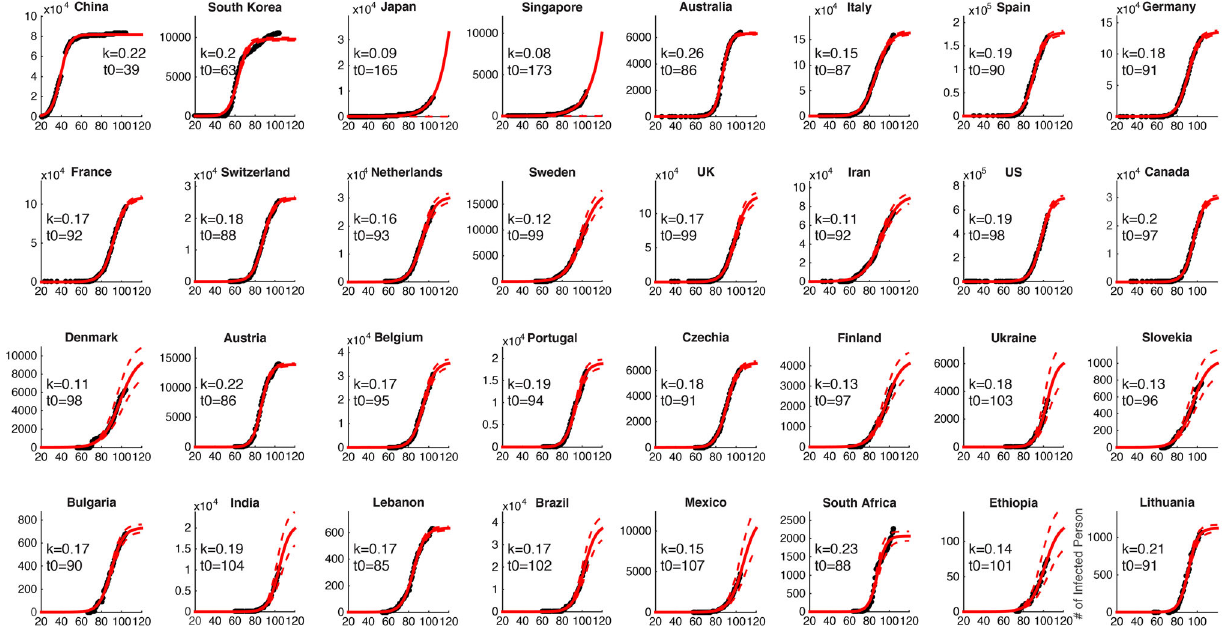
Fig. 6 Intrinsic growth rules of patients infected with the 2019 novel coronavirus in China and 31 other countries around the